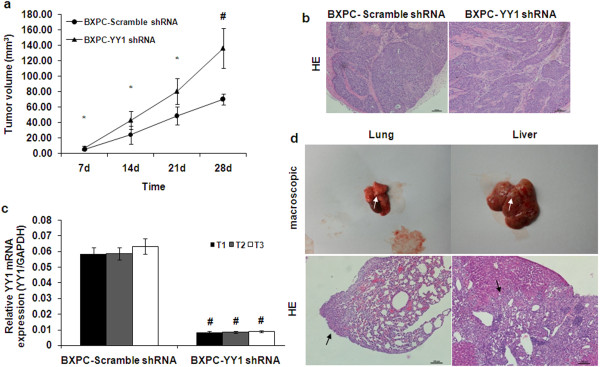
Effects of YY1 on the tumor growth and metastasis of BXPC-3 cells in vivo. (a) BXPC-Scramble shRNA and BXPC-YY1 shRNA cells were bilaterally injected into the flank region of the mice (1.5 × 106 cells/100 μl per flank). After injection, the length and width of the tumors were measured every week. The volume of the tumors was calculated using the formula (width2 × length)/2. The data are presented as means ± SD of 16 tumors for each group. (b) HE staining of the subcutaneous tumors excised four weeks later. Scale bar, 100 μm. (c) Three tumors from each group were resected, RNA was extracted and YY1 expression was measured using qRT-PCR. (d) BXPC-Vector and BXPC-YY1 cells (1.5 × 106 cells/100 μl) were separately injected into the tail vein of each mouse. Four weeks later, lung and liver metastases were evaluated by macroscopic observation and by histomorphology under microscopy. Scale bar, 100 μm. The arrows indicate the metastases. (* represents p < 0.05, # represents p < 0.001, compared with the control group).